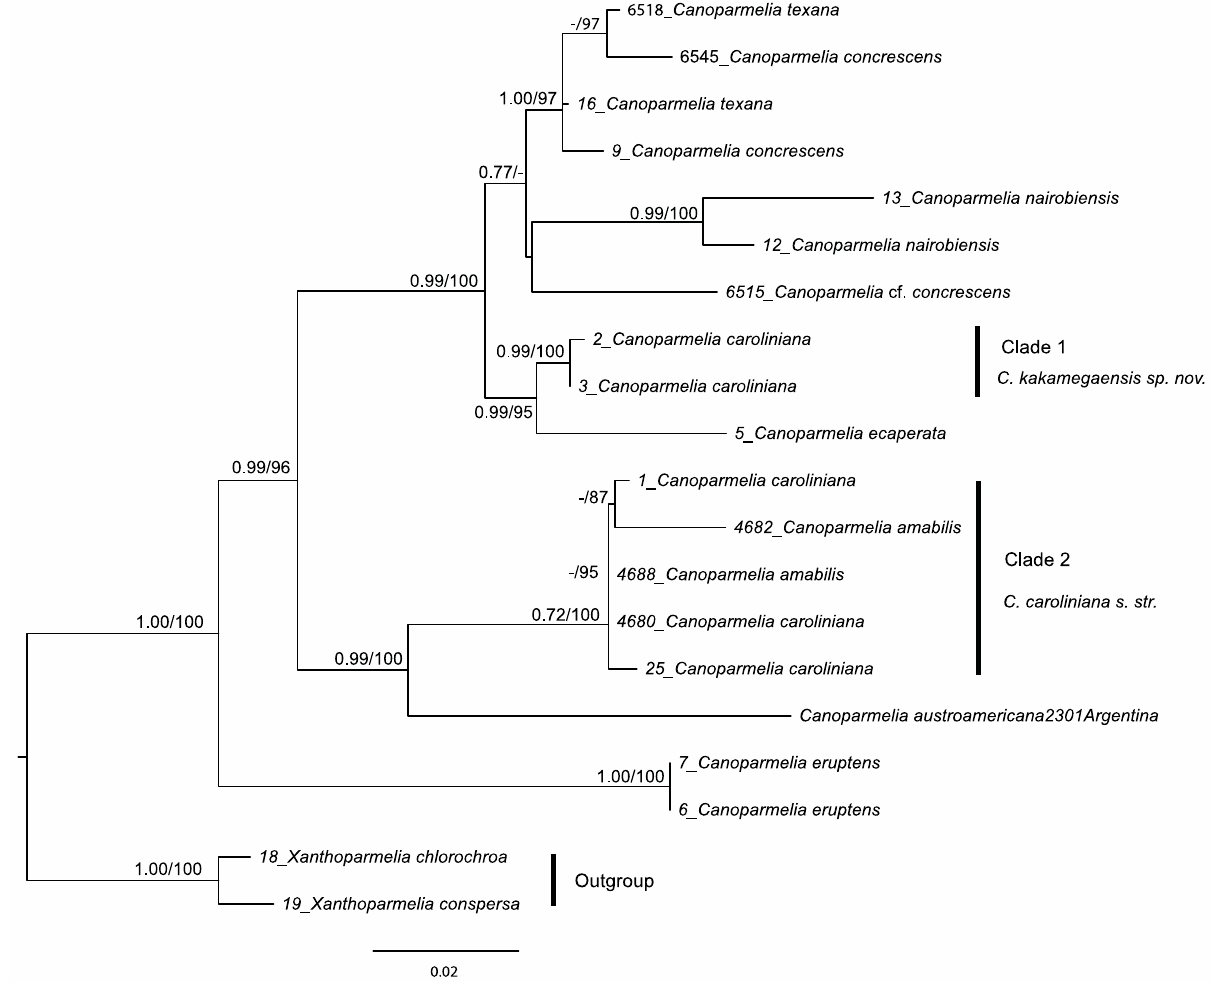
Figure 1. The phylogenetic relations of Canoparmelia species based on maximum likelihood (ML) and Bayesian analyses of a concatenated, three-locus data set (ITS, nuLSU and mtSSU rDNA). The ML tree is depicted here. Posterior probabilities ≥ 0.95 from the Bayesian analysis and ML bootstrap values ≥ 70% are provided above branches.